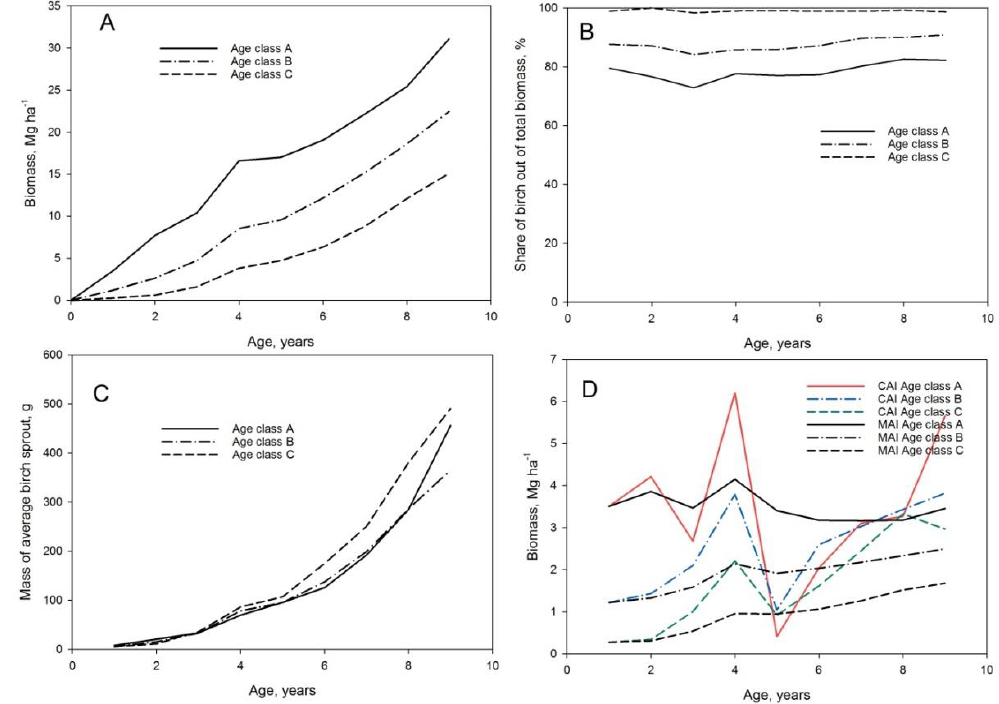
Figure 5. Biomass of sprouts ( A ), share of birch out of total biomass ( B ), biomass of average birch sprout ( C ), and MAI and CAI of birch and willow in the age classes ( D ).